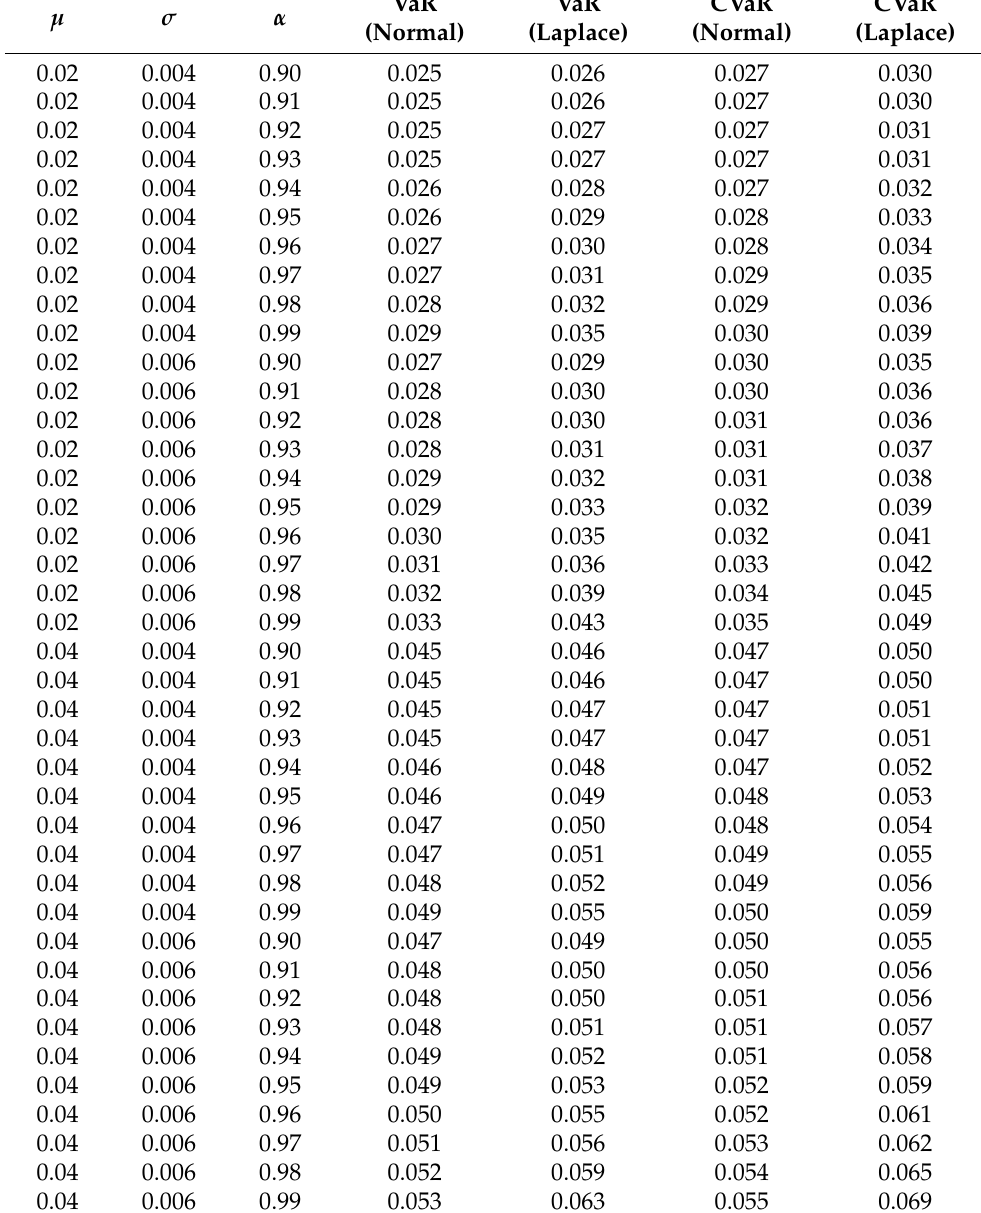
Table 1. Comparisons of the normal and Laplace distributions in terms of the observed risk